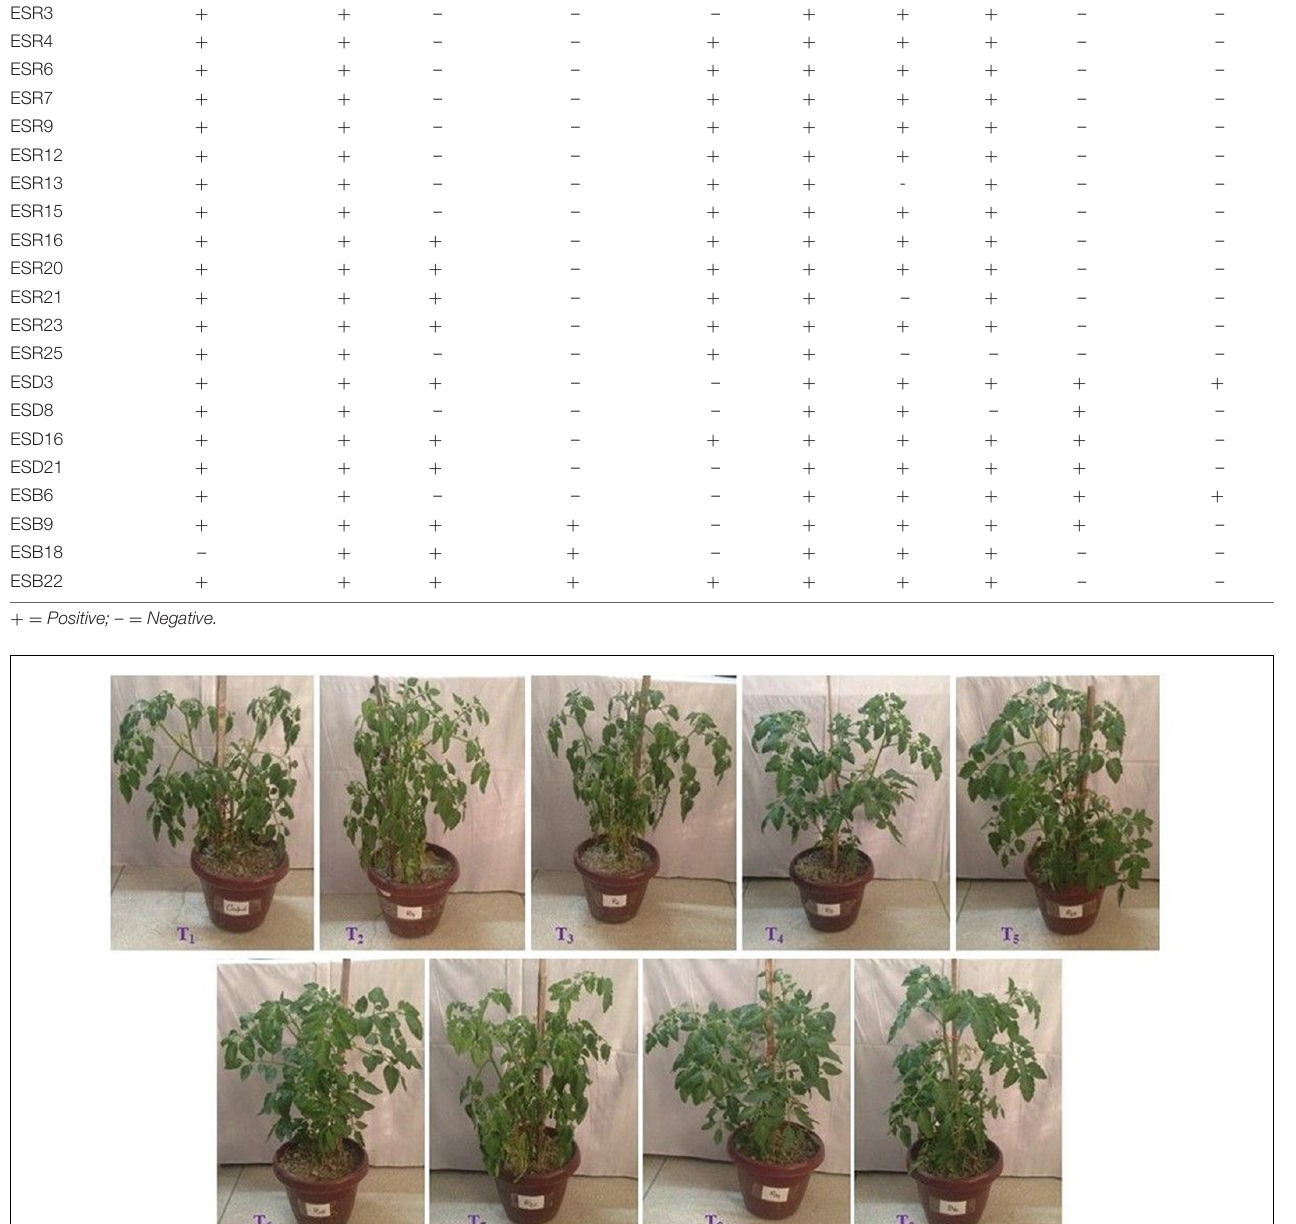
TABLE 4 | Abiotic stress tolerance of different biofilm-producing rhizobacterial strains. Drought Temperature ( ◦ C) pH Strains